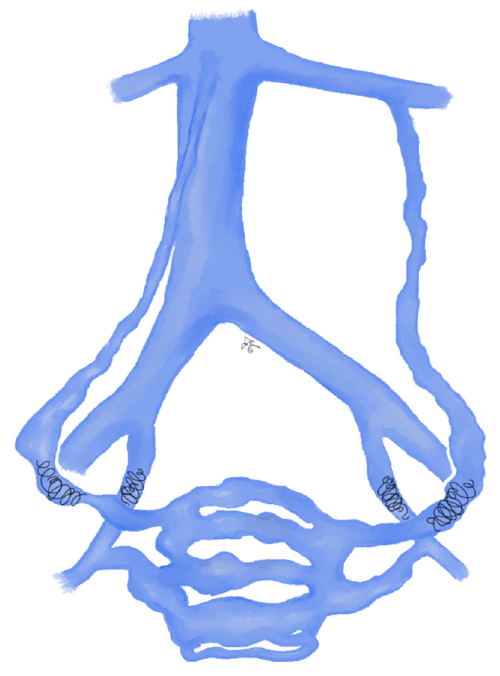
Figure 5. Drawing shows left and right ovarian veins and left and right hypogastric veins embolization with coils, as reported by Laborda et al.